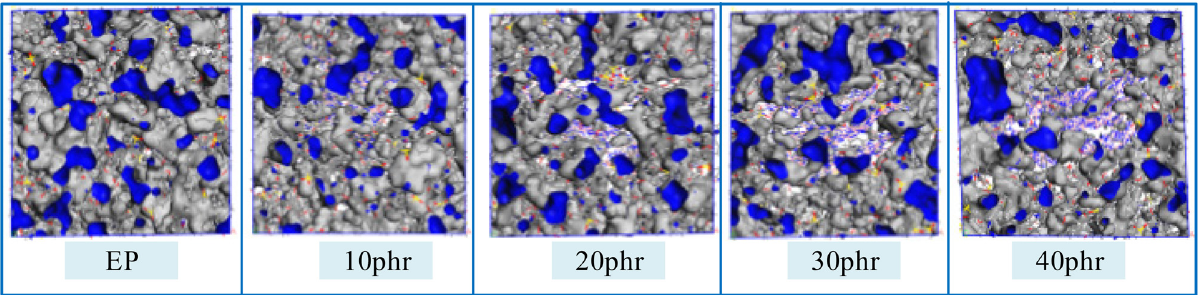
Figure 8: Free volume distribution of di ff erent model.